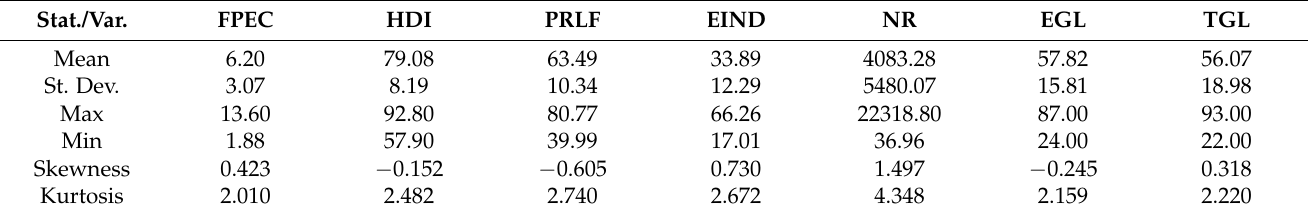
Table 2. Descriptive